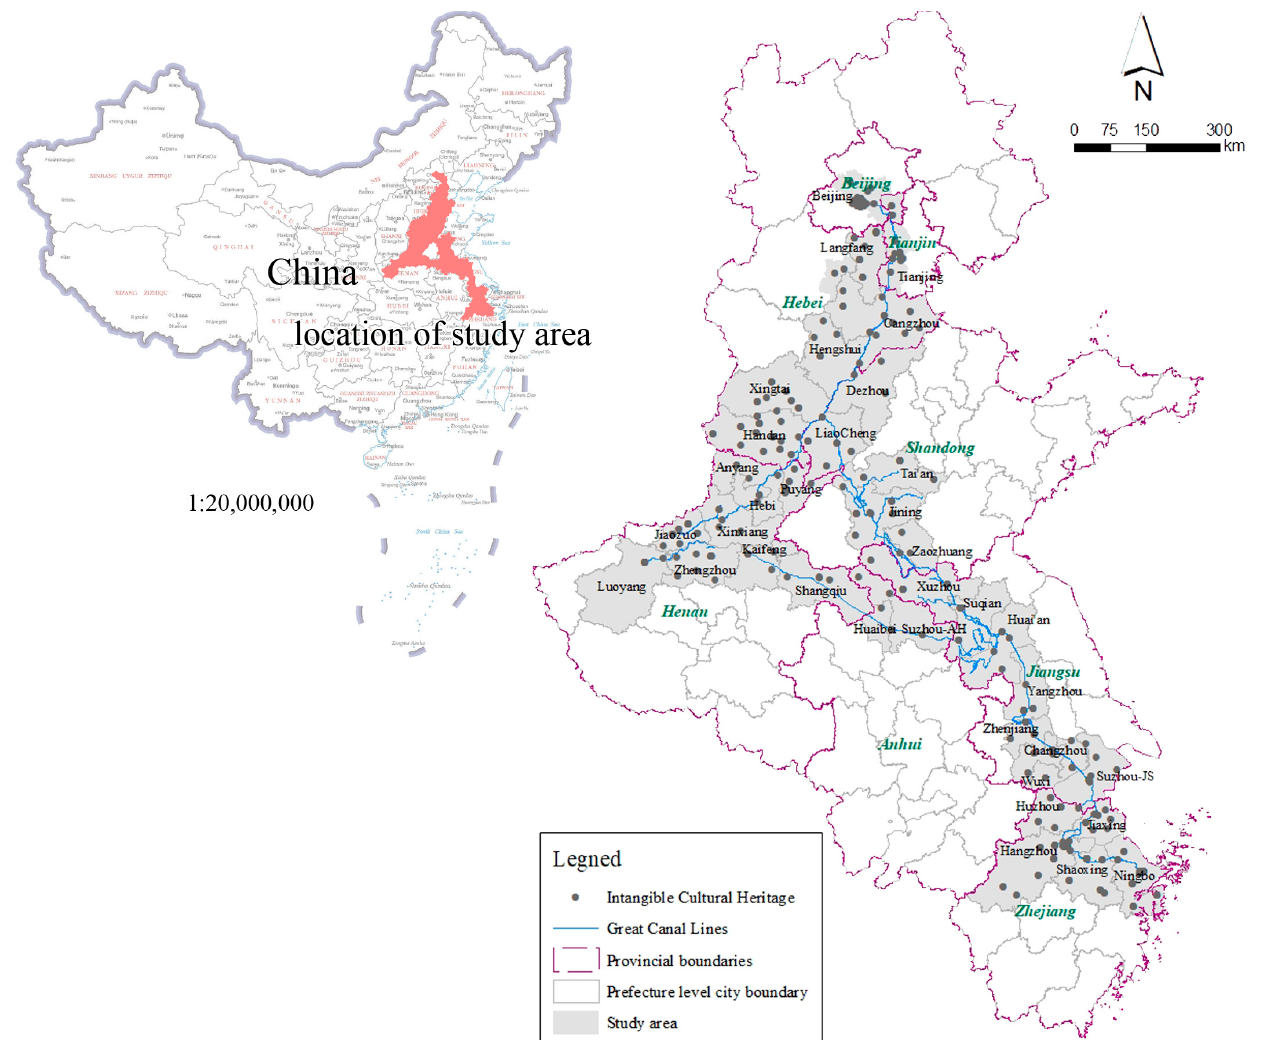
Figure 1. Map of the study area and the spatial distribution of ICH resources along the Grand Canal in China.